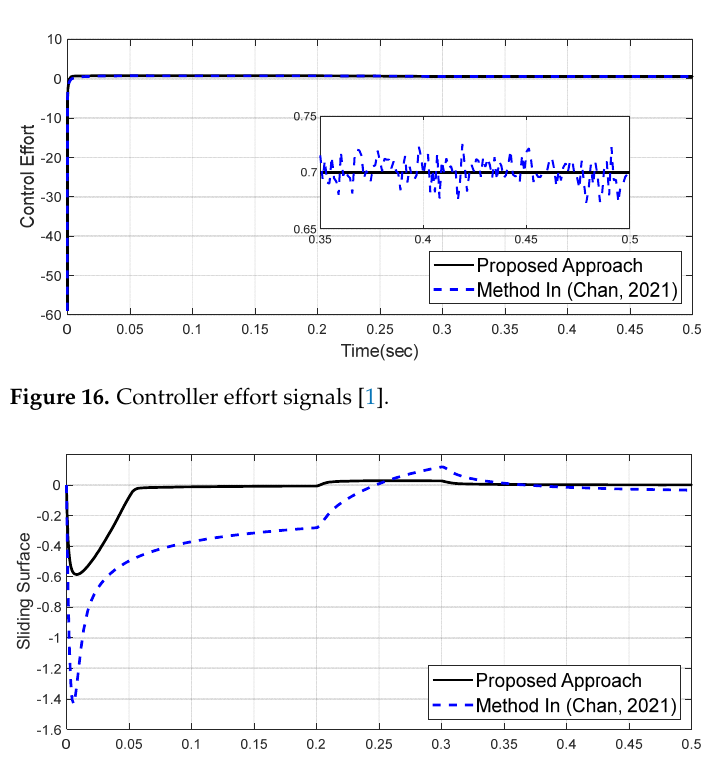
Figure 15. Comparison of the behaviour of the inductor current and output voltage with the results of the method in Ref. [1] in case of output voltage changes.